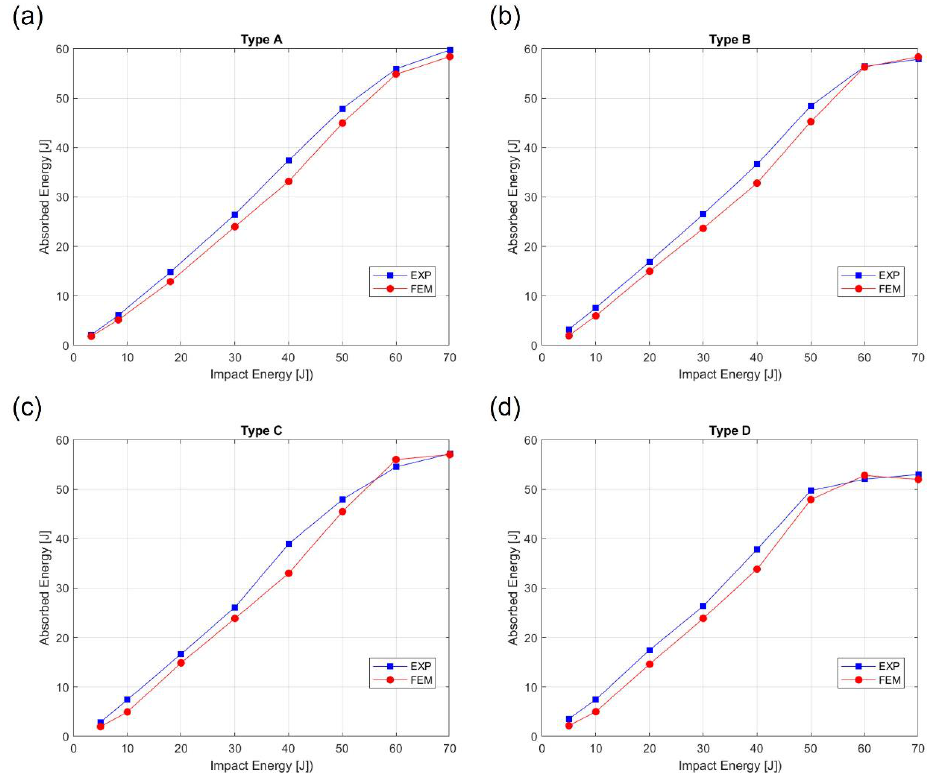
Figure 11. Absorbed energy as a function of impact energy. Experimental and numerical results comparison for all the bumper beam types. ( a ) E abs -E imp for Type A; ( b ) E abs -E imp for Type B; ( c ) E abs -E imp for Type C; and ( d ) E abs -E imp for Type D.